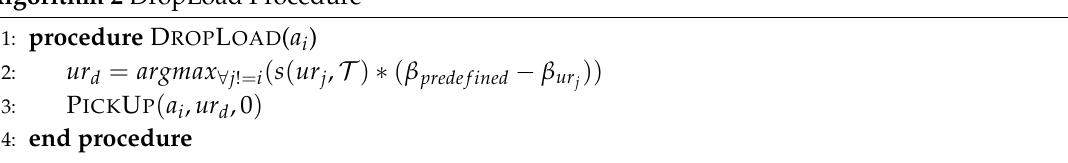
Algorithm 3 PickUp